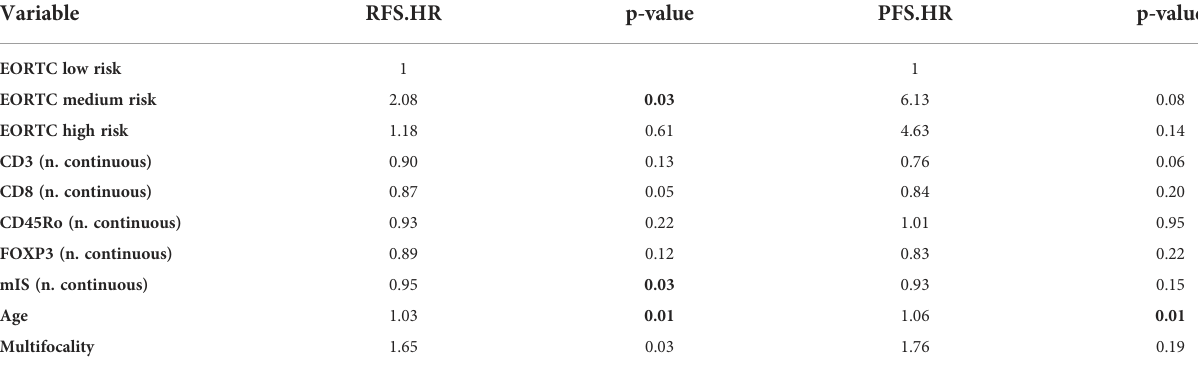
TABLE 2 Univariable cox regression analysis. Variable